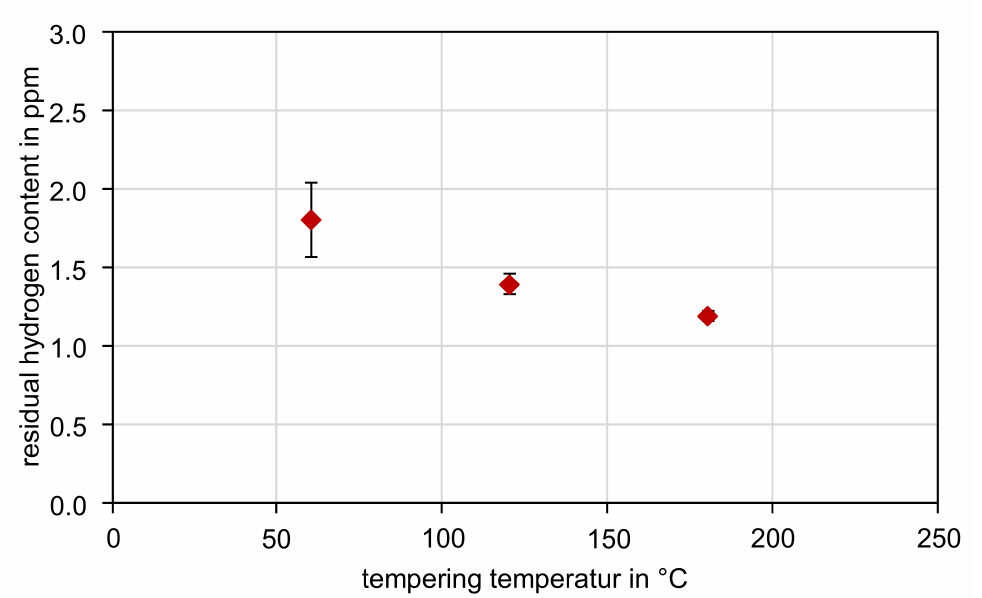
Figure 8. Development of residual hydrogen content (melt extraction) as a function of annealing temperature following a low hydrogen annealing at 210 ◦ C for 24 h (x ± s, n =